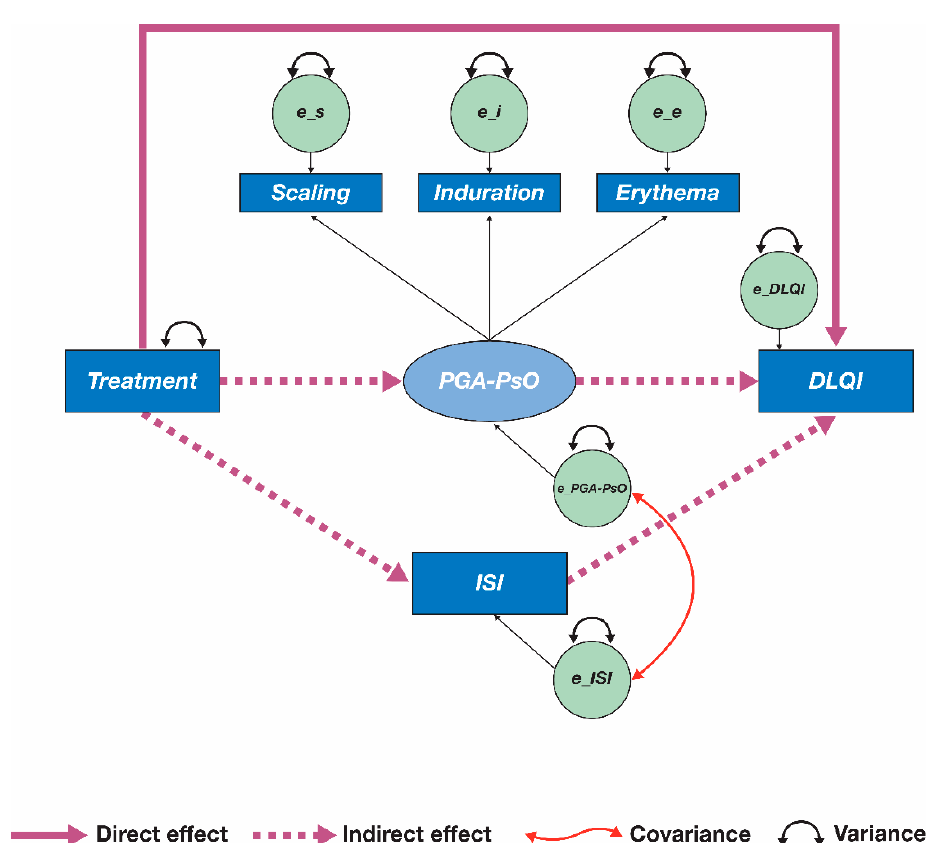
Figure 1. Initial mediation model. Treatment is represented by a binary variable (tofacitinib 5 mg twice daily [value of 1] versus placebo [value of 0]); the error terms for Physician Global Assessment of Psoriasis (e_PGA-PsO) and Itch Severity Item (e_ISI) are connected by a curved two-headed arrow, indicating that these two variables are allowed to covary (meaning that the variables ISI and PGA-PsO are not assumed to be independent). A curved two-headed arrow pointing to the same variable represents variance. DLQI, Dermatology Life Quality Index; e_DLQI, error term for DLQI; e_e, error term for erythema; e_i, error term for induration; e_s, error term for scaling.